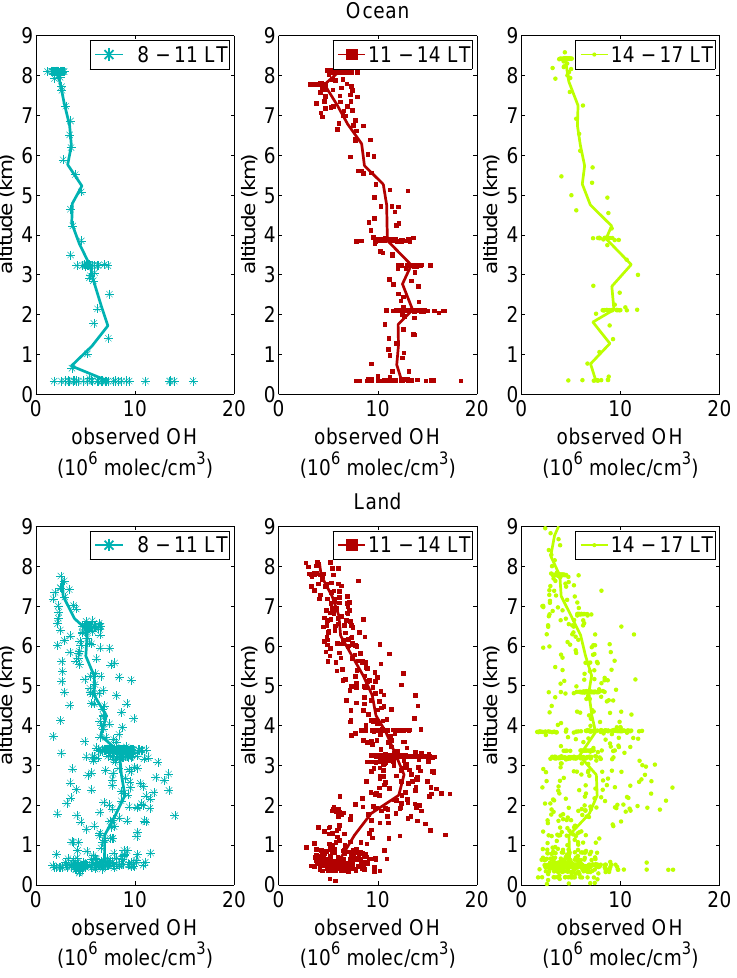
Fig. 2. OH (30 s average) observed for all flights as a function of altitude. The thick line denotes the mean values in 500 m bins. Upper row represents the situation over the ocean for different times of the day (left to right panel), lower row shows the situation over land.